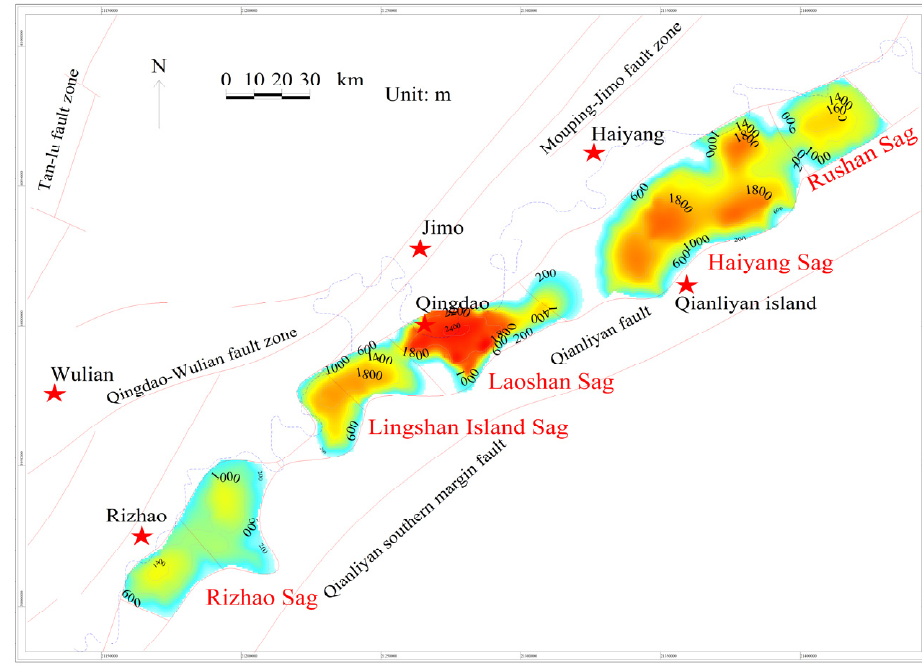
Figure 2. Contour map of formation thickness of the Laiyang Formation in the Ri-Qing-Wei Basin.